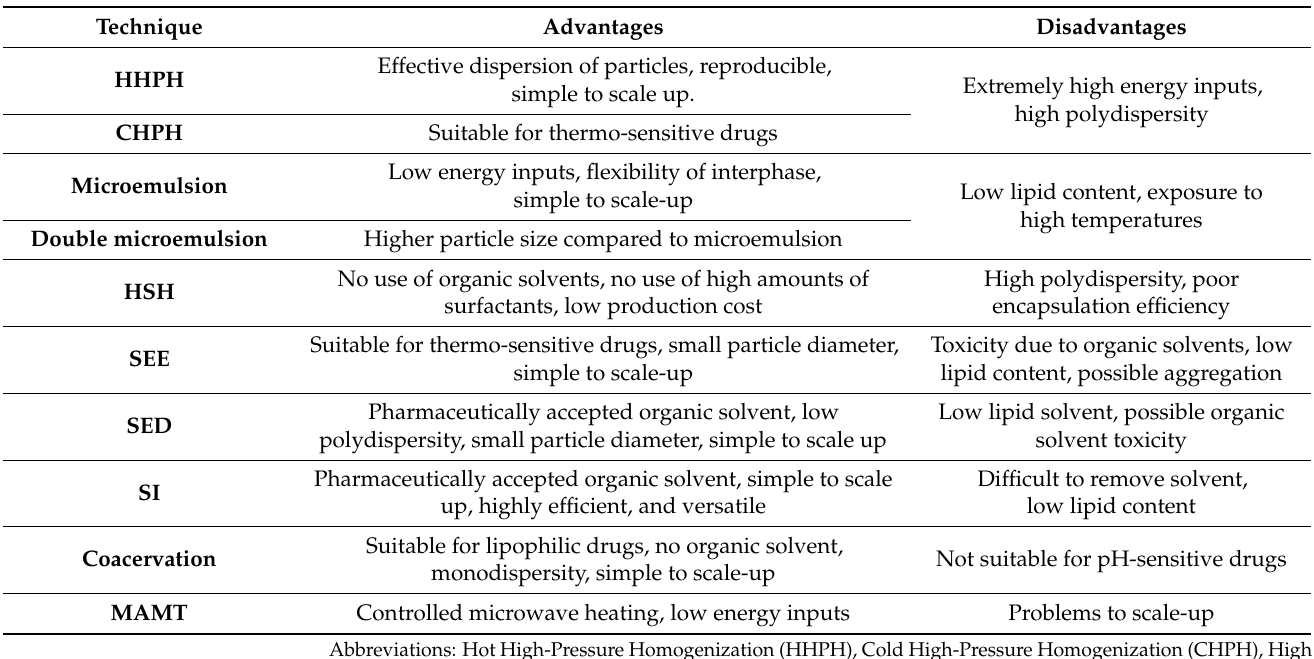
Table 2. Advantages and disadvantages of the different SLN production